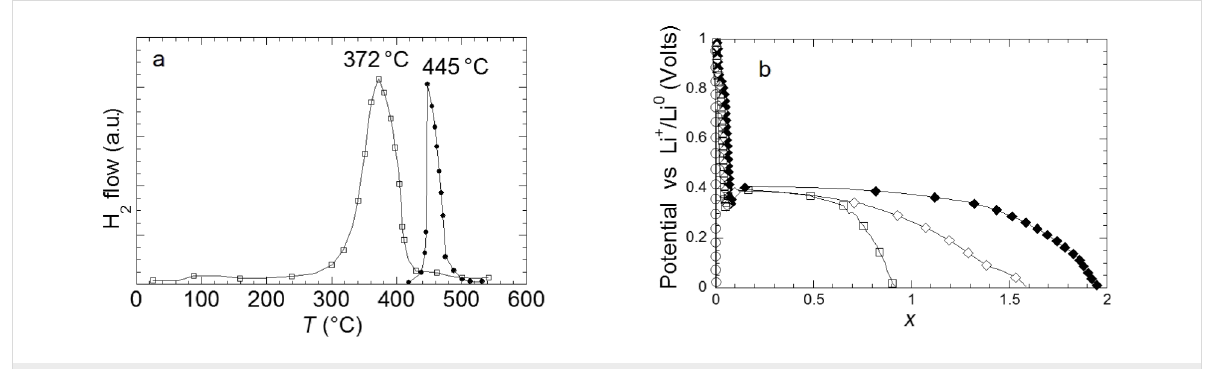
Figure 11: a) DSC traces of commercial MgH 2 unground and ground for 20 h. b) Evolution of the potential (V) as a function of x (mole fraction of Li) for a MgH 2 electrode prepared with commercial hydride ground for 20 h in the Spex mixer mill and cycled between 3 and 0.005 V at a rate of one